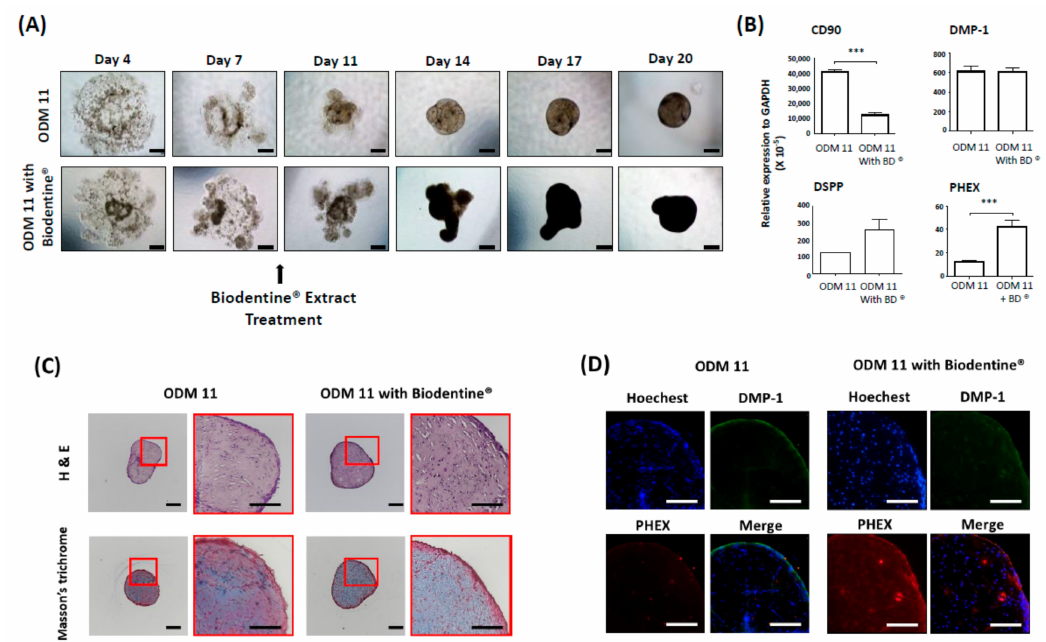
Figure 5. ODM 11 demonstrated biologically active response to Biodentine ® extract treatment. ( A ) During the fabrication of ODM 11, 40 mg / mL of Biodentine ® , which was previously reported to enhance odontogenic di ff erentiation and approved by the US FDA, was additionally added into the ODM. Under a light microscope examination, faster cell aggregation and more condensed organoid formation were detected compared to ODM 11. Scale bar = 100 µ m. ( B ) In the Biodentine ® exposure group, CD90 expression level was significantly decreased, while the expression level of PHEX, a terminal di ff erentiation marker of odontoblast, expression, was significantly increased. *** indicate p < 0.05 and p < 0.001, respectively. ( C ) Biodentine ® increased collagen formation, which was assessed by Masson’s trichrome staining. Scale bar = 100 µ m. ( D ) Positive immunofluorescence staining for DMP-1 and PHEX. Magnification: 40 ×